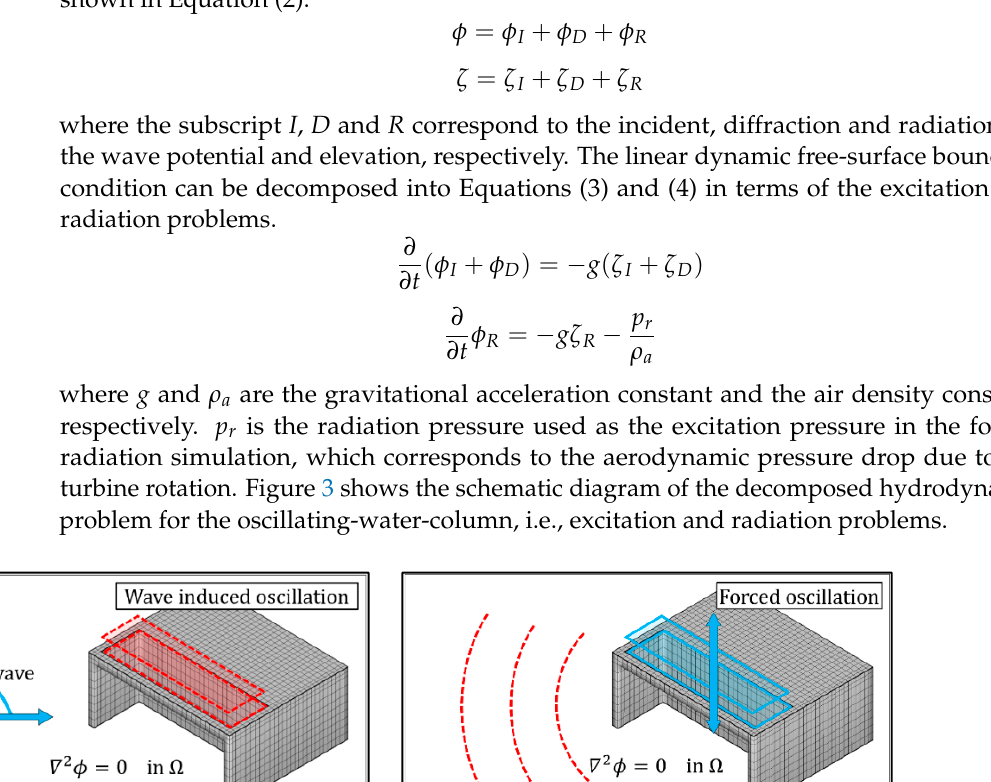
Figure 3. Schematic diagram of decomposed hydrodynamic problem of oscillating-water-column energy conversion mechanism: ( a ) wave excitation problem; ( b ) forced radiation problem.